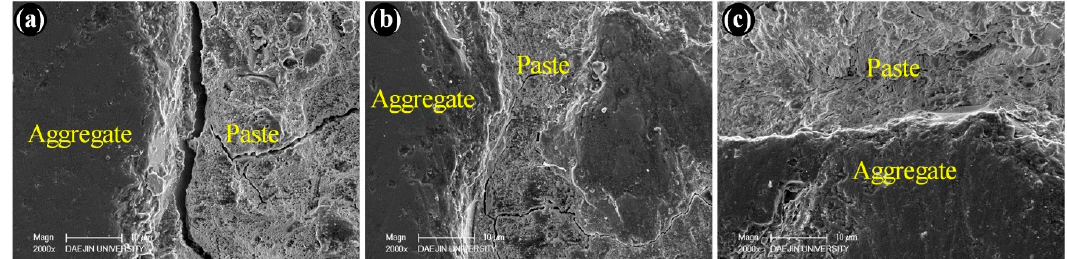
Figure 7. SEM micrographs of plain concrete made with ( a ) basalt, ( b ) quartzite, and ( c ) granite coarse aggregates.